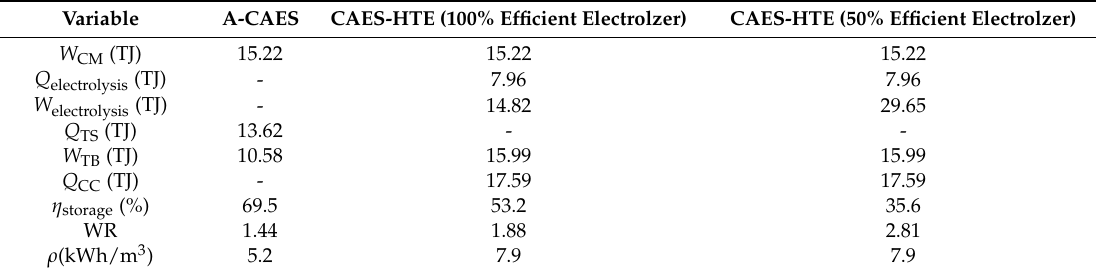
Table 2. Simulation results for the A-CAES and CAES-HTE systems simulated in the base case